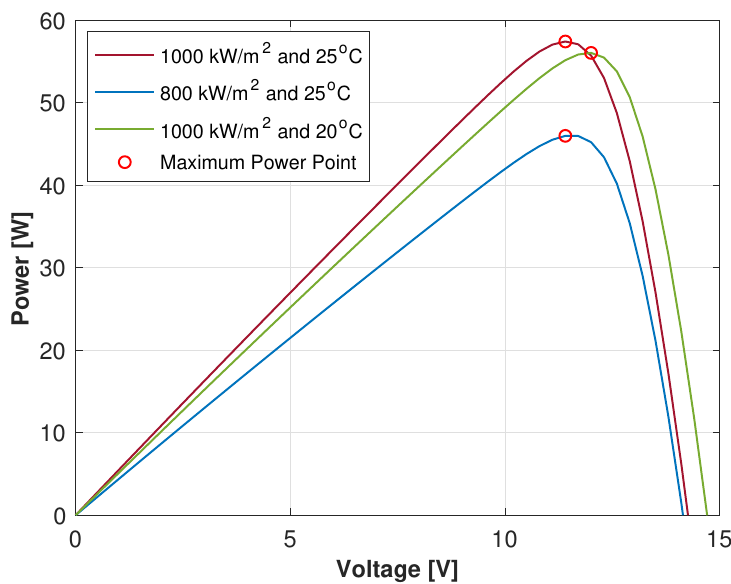
Figure 3. Power against Voltage profiles, for different Irradiances and Temperatures input